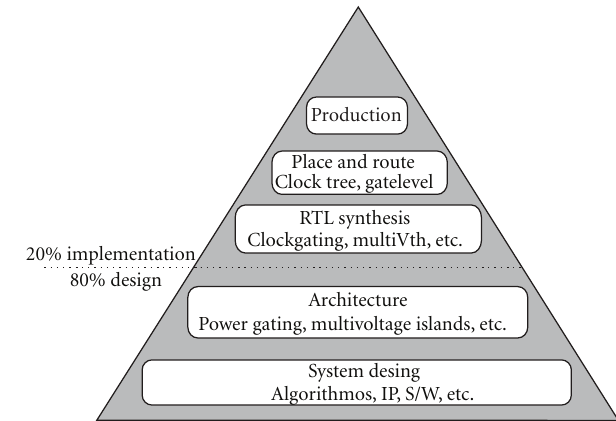
Figure 1: Impact factor of power savings [19].